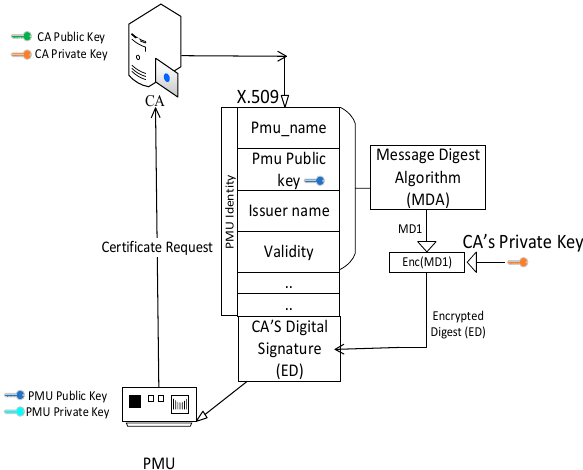
Figure 8. Signing of digital certificate by a certificate authority (CA).